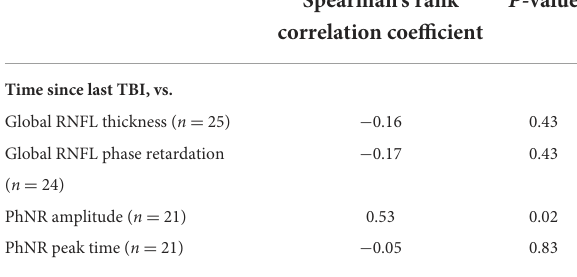
TABLE 7 Associations between time since last traumatic brain injury (TBI) and retinal nerve fiber layer (RNFL) structural parameters and electroretinography functional parameters in case subjects.